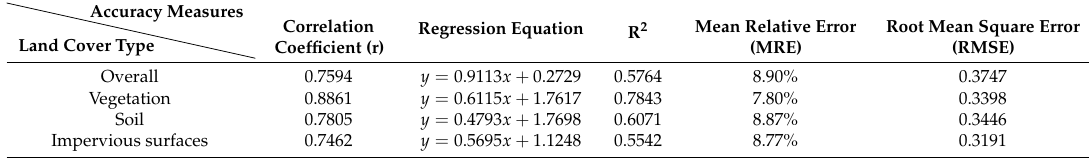
Table A2. The result of daily evapotranspiration of Wuhan’s urban built-up area on 8 August 2013 is obtained through our modified model and given in Figure 18. Table 11. Linear relationship between our modeled ET and the China -ASEAN ET product for each land cover type (vegetation, soil, and impervious surfaces) in Wuhan testing area.